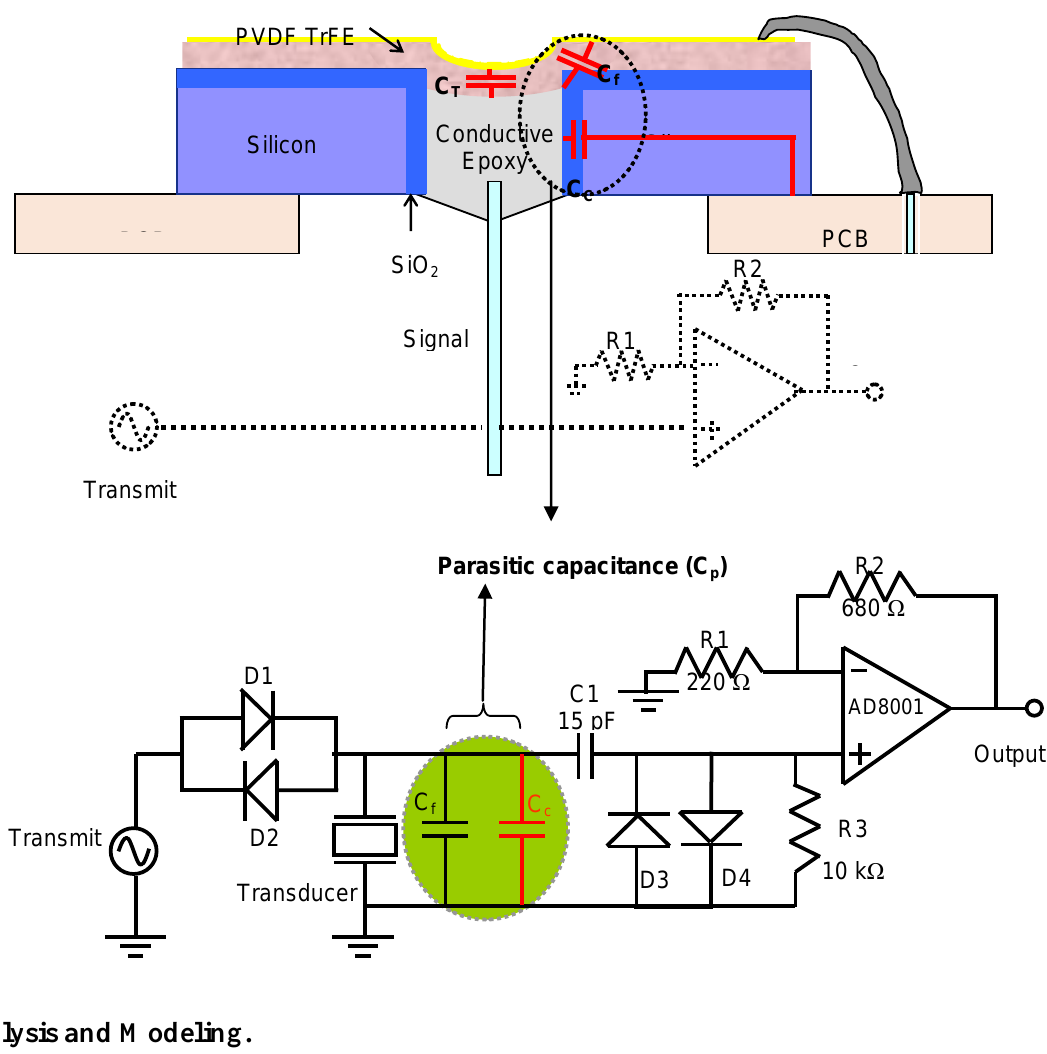
Figure 2. Cross-sectional diagram and schematic of the device showing the inherent and parasitic capacitances associated with the